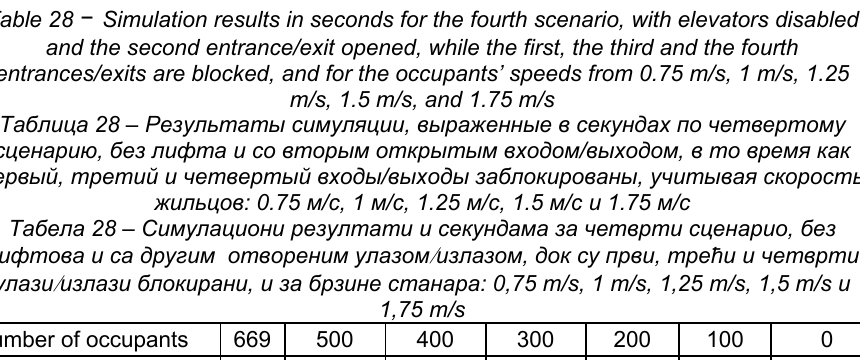
Table 28 – Simulation results in seconds for the fourth scenario, with elevators disabled and the second entrance/exit opened, while the first, the third and the fourth entrances/exits are blocked, and for the occupants’ speeds from 0.75 m/s, 1 m/s, 1.25 m/s, 1.5 m/s, and 1.75 m/s